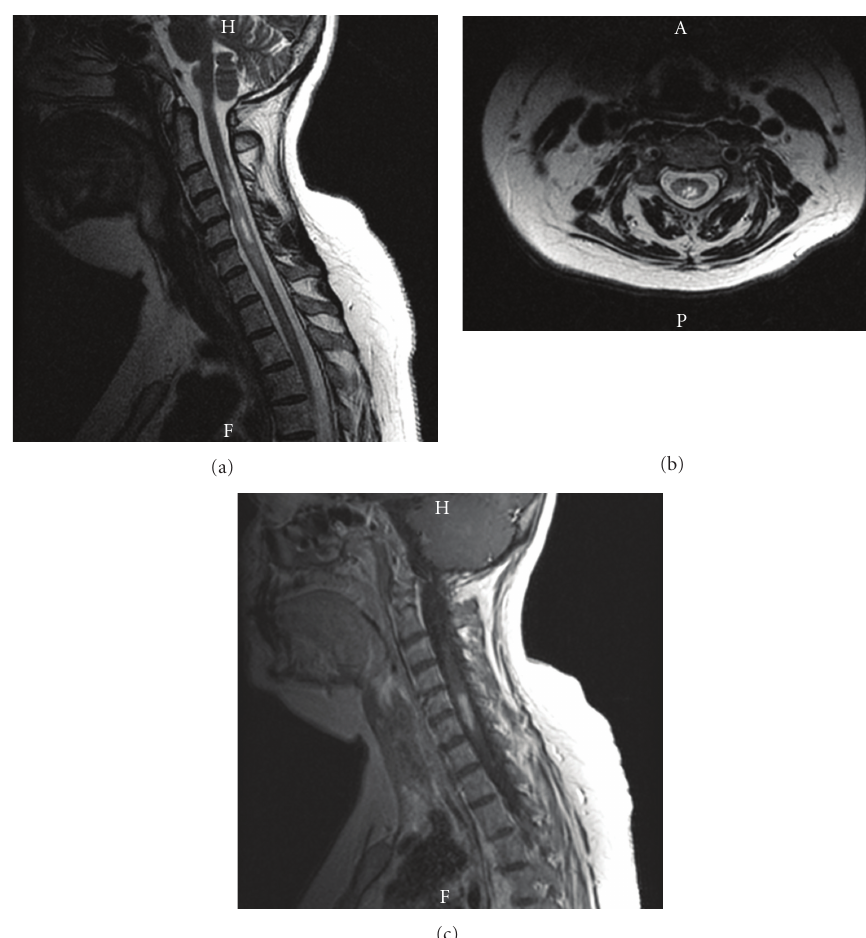
Figure 1: An MRI showing a longitudinally extensive cervical spinal cord lesion in a patient with NMO. (a) T2 weighted sagittal MRI sequence shows T2-hyperintensity extending beyond 3 spinal cord levels. (b) T2-weighted axial sequence shows bilateral T2 hyperintensity in the central/dorsal cord. (c) T1-weighted sagittal sequence with gadolinium contrast shows enhancement in a significant portion of the